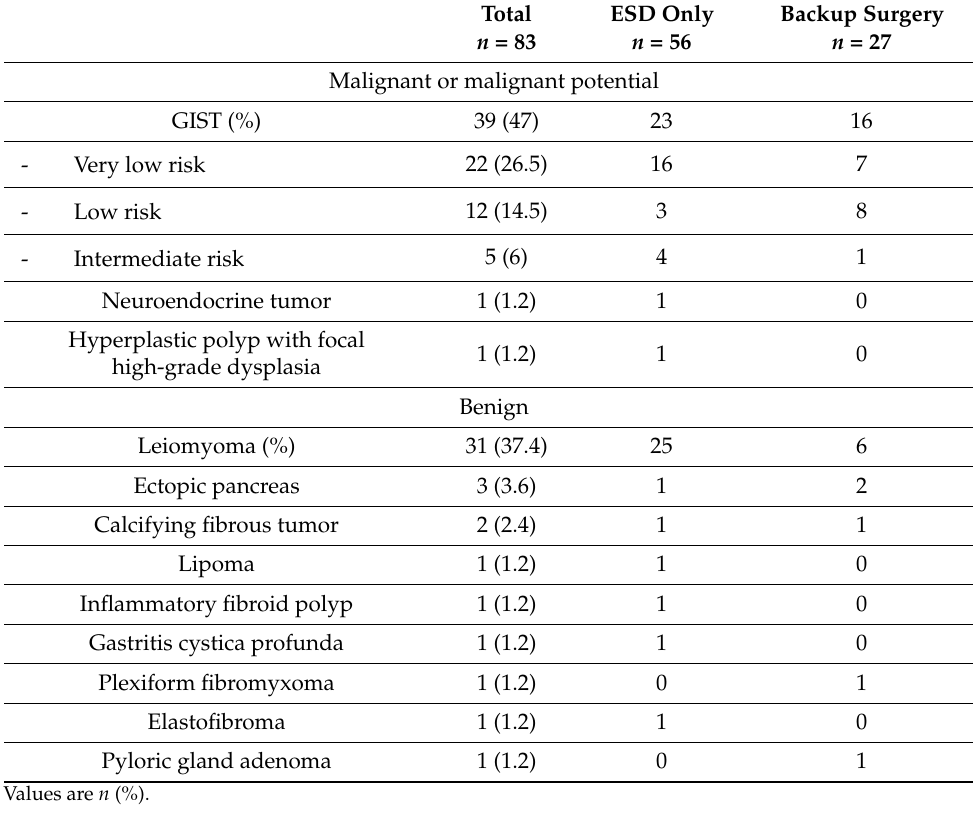
Table 3. Pathologic diagnoses of 83 patients with gastric subepithelial tumors.